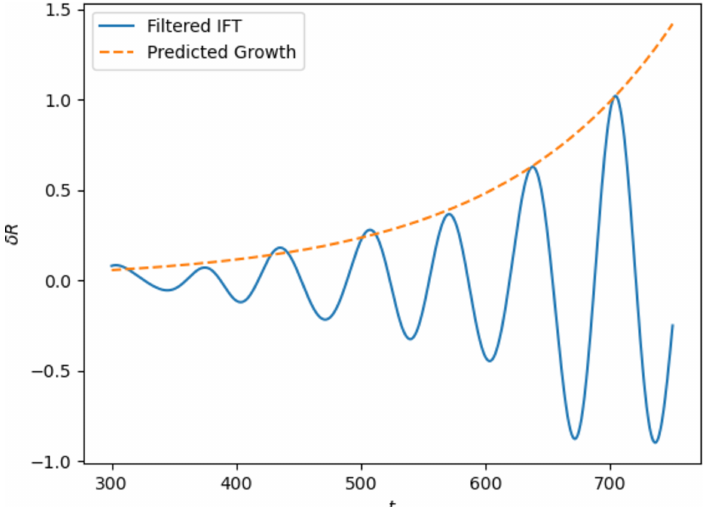
Figure 26 . Comparison of the approximate oscillations caused by the square mode and the rate of growth predicted by the semi-analytic method, in parameter set A. The square mode was isolated by using a top hat function to select a small frequency range (that it lies within) and then performing an inverse Fourier transform, which has been cut off at early times when the square mode was not the dominant oscillation. The predicted growth of Ae Im (Ω 4 ) t with Im (Ω ) = 0 . 0072 fits the envelope 4 of this signal well, where A is chosen so that the envelope intersects the largest